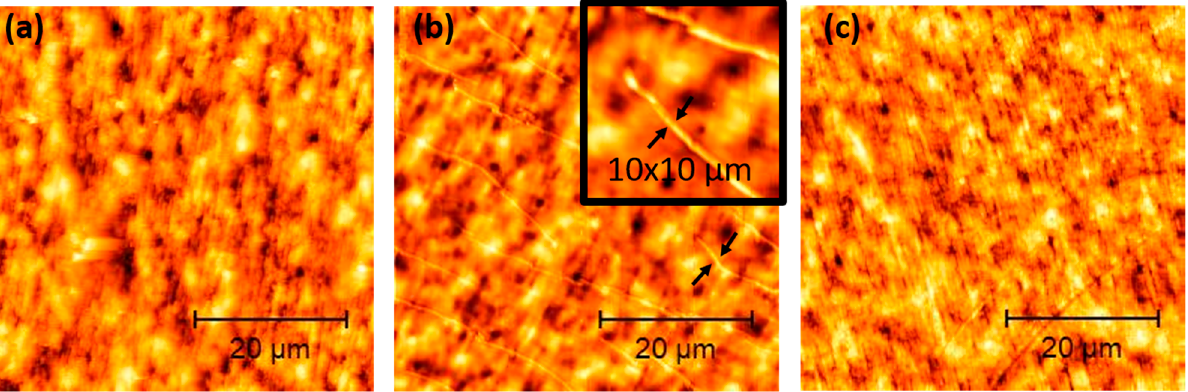
Figure 7. AFM images of ( a ) untreated PBS, ( b ) PBS coated with a SiO x layer, and ( c ) PBS coated with SiO x C y H z (25 nm thickness) + SiO x ). SiO x C y H z (25 nm thickness) + SiO x